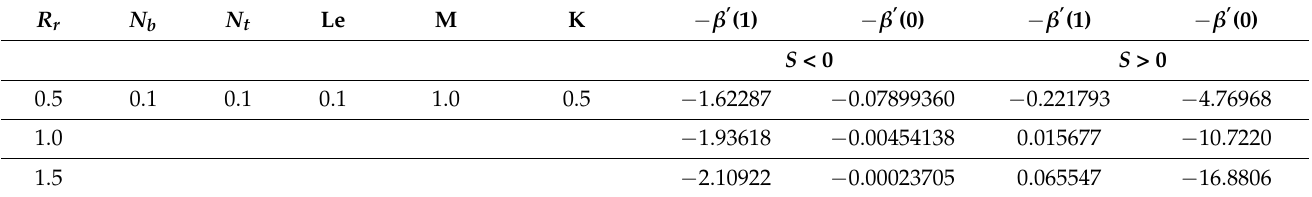
Table 12. Local Sherwood number for γ Al 2 O 3 − C 2 H 6 O 2 at lower and upper plane with strong interaction n =